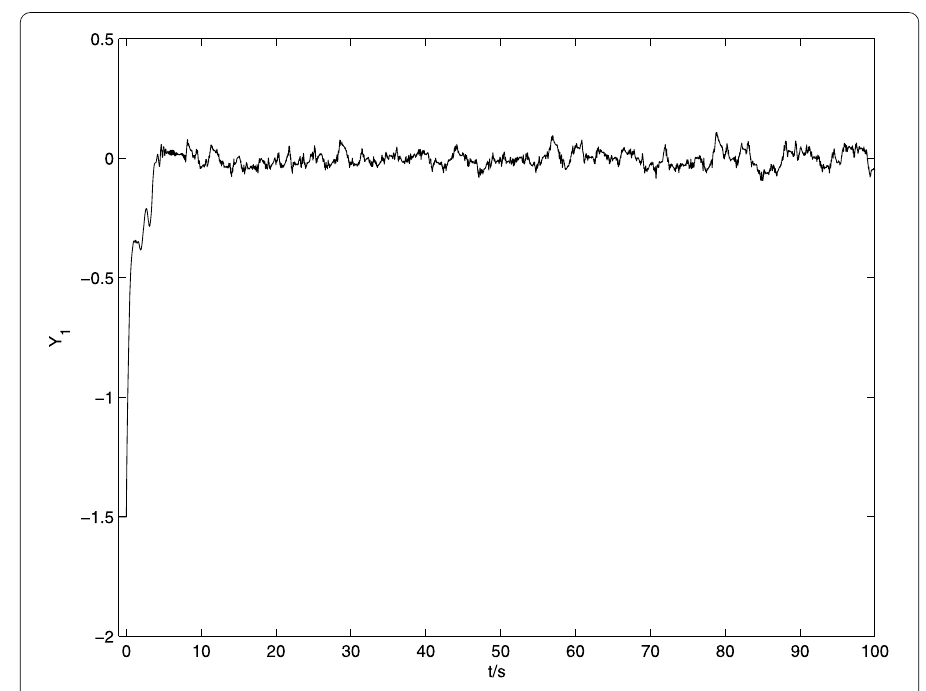
Figure 3 Time response of output variable Y 1 ( t ) of the Lurie system